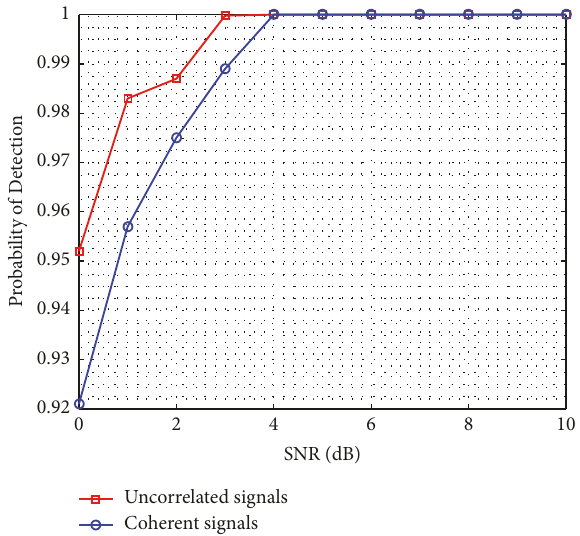
Figure 3: The resolution probability versus the angular gap. Figure 4: The detection probability versus the SNR with 𝑁 푃 = 100 .